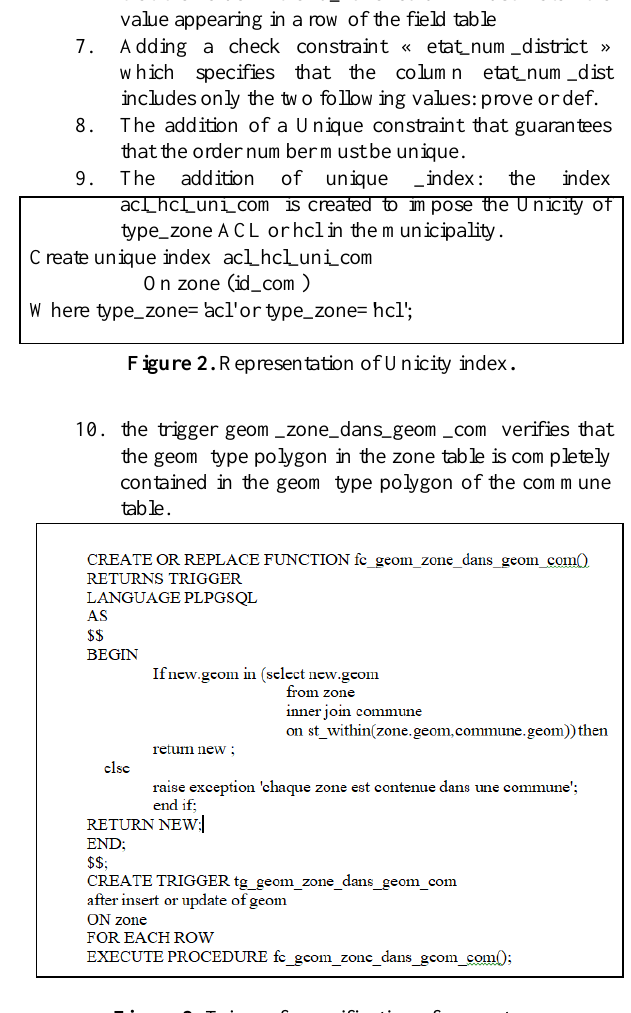
Figure 3. Trigger for verification of geometry The same aspect is used for the other tables in the database, the following figure represents the complete model after adding all constraints, relational and